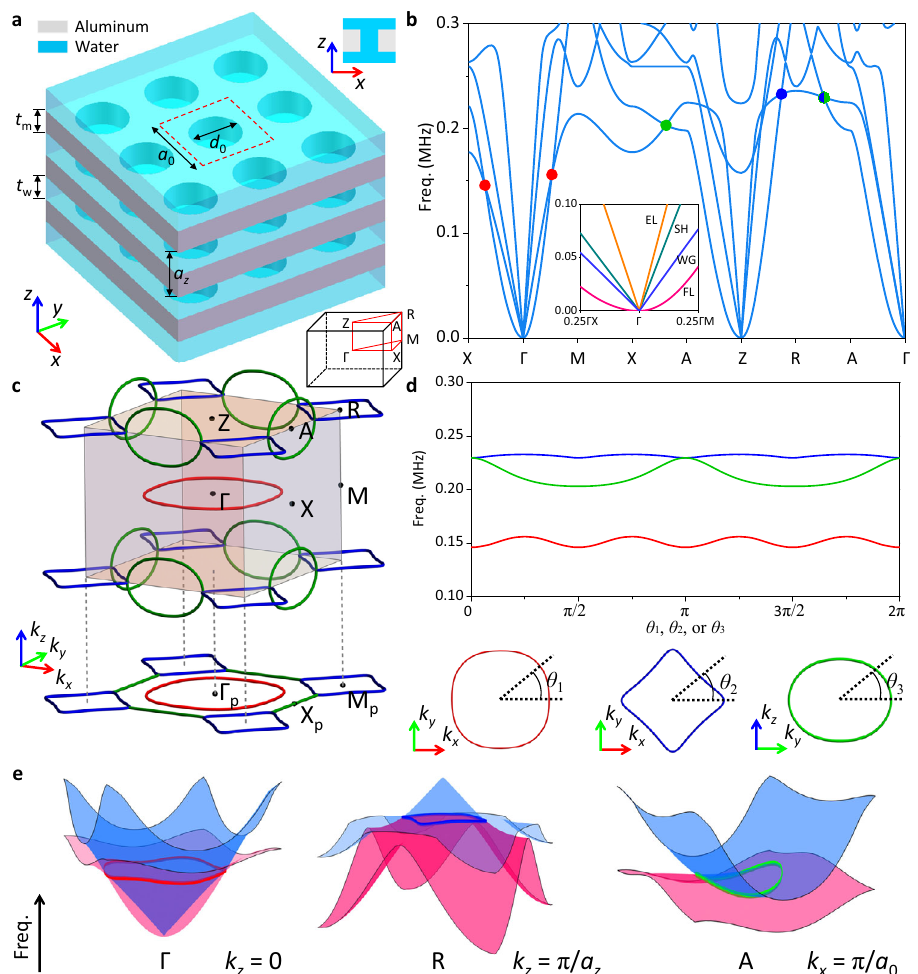
Fig. 1 | Type-II nodal rings induced by fl uid-solid interaction. a Perspective and cross-sectional views of the 3D phononic crystal, formed with identical aluminum plateswithcircularthroughholesimmersedinwater.Thephononiccrystalbelongs to the space group P4/mmm (No. 123). Inset: schematic of the fi rst Brillouin zone (FBZ). The red dashed square indicates a single unit cell ( z direction not shown). The in-plane lattice constant a 0 =3mm, the diameter of holes d 0 =2mm, the thicknessof plates